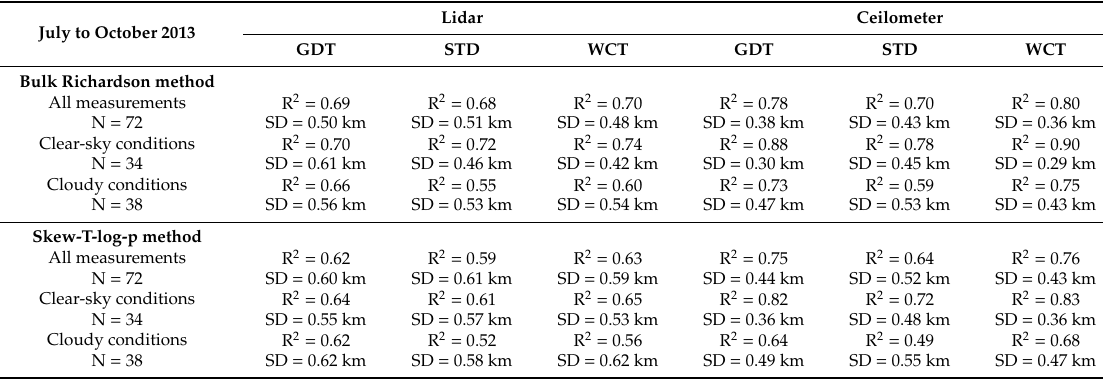
Table 2. The correlation coe ffi cient (R 2 ) and the standard deviation (SD) of the ABLHs derived from lidar and ceilometer by using the GDT, STD, and WCT methods versus the ABLHs derived from rawinsonde by using the skew-T-log-p and the bulk-Ri methods. Results obtained during clear-sky and cloudy conditions from July to October